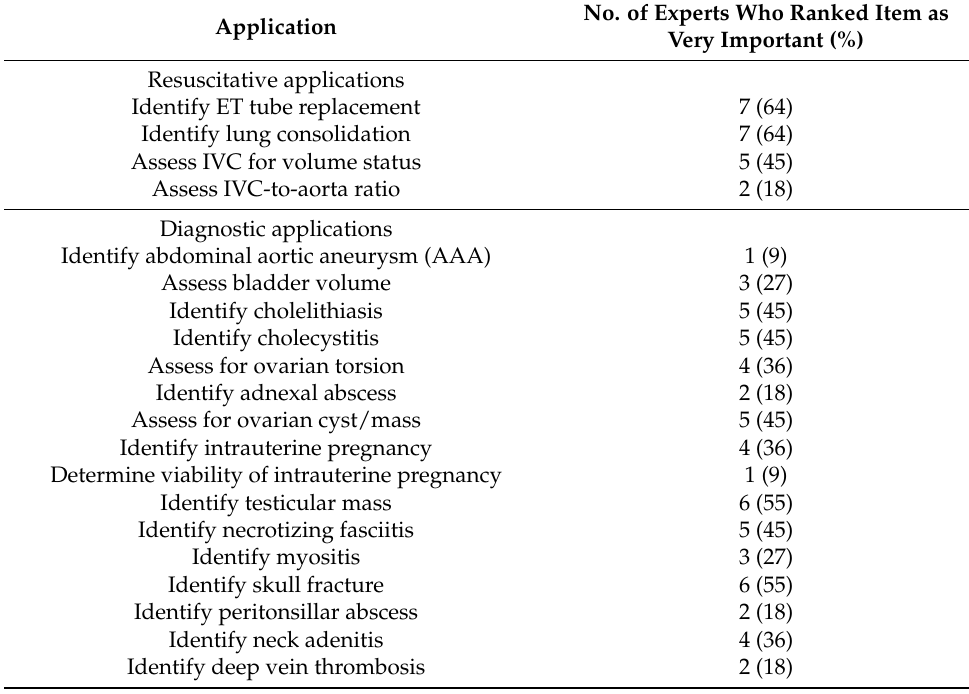
Table 4. POCUS Applications with No Consensus to Include or Exclude by Delphi